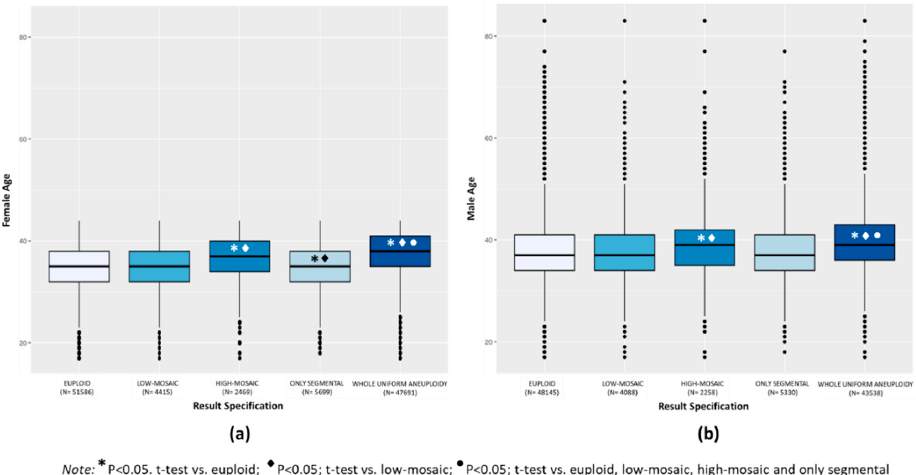
Figure 1. Box plot distribution of mean maternal age ( a ) and mean paternal age ( b ) expressed in years in the results categories of euploid, low-mosaic, high-mosaic, only segmental, and whole uniform aneuploid TE biopsies.